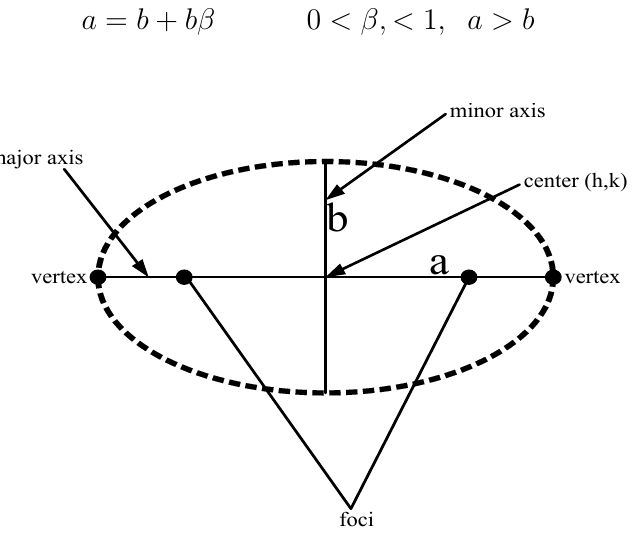
Figure 5. Elliptical trajectory of the